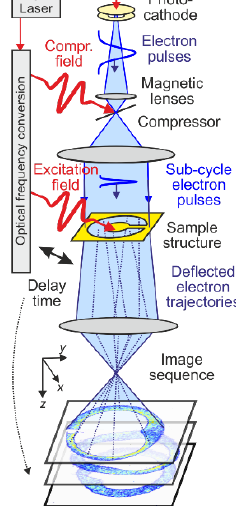
Fig. 1 . Concept and experimental setup (TEM geometry). Optical pulse compresses electrons in time and also triggers electromagnetic resonances in the